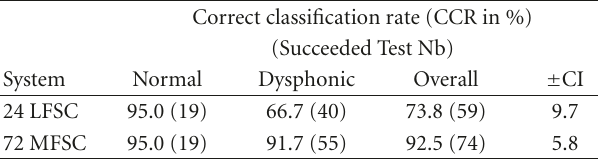
Table 1: Performance of the normal and dysphonic voice classifica- tion (Task1) expressed in terms of correct classification rate (CCR in %) as well as the number of succeeded tests (in parentheses) on the DV corpus according to two parameterization configurations (24 LFSC and 72 MFSC). Confidence intervals (CIs) are provided for the overall